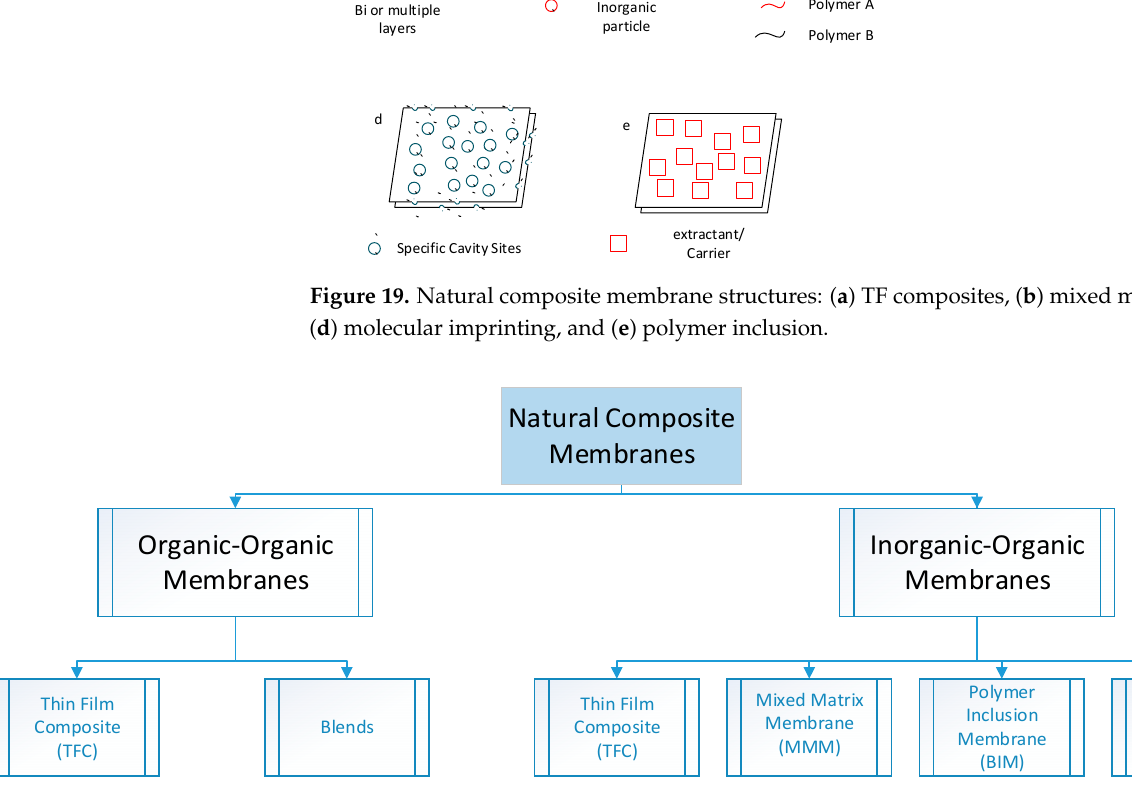
Figure 20. Types of composite membranes.